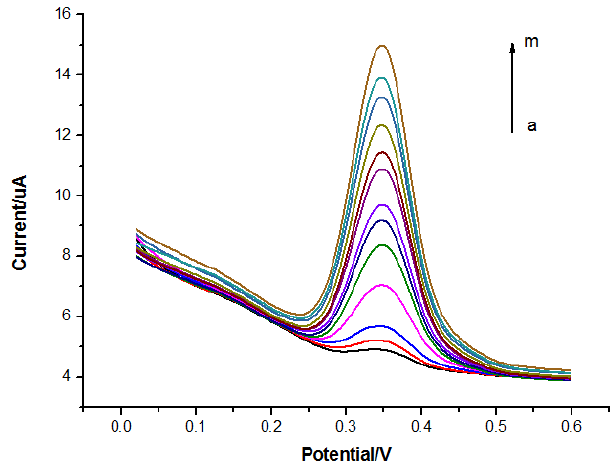
Figure 6. Differential pulse voltammetry on the concentrations of quercetin in the range